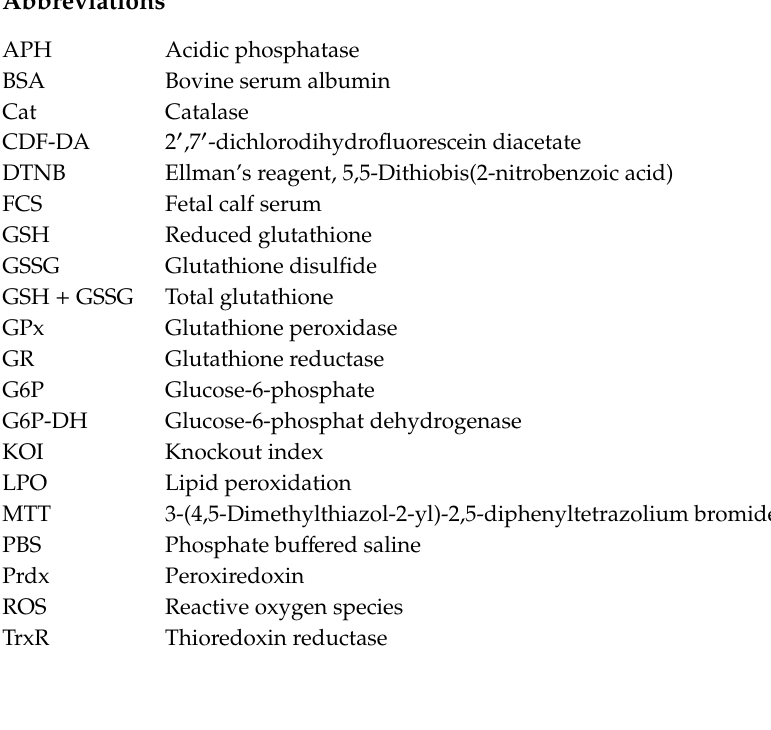
Figure S1: Position of the frameshift mutation within the GPx1 gene, Figure S2: Sequencing result of clone, mapped on NM_000581, Figure S3: Representative western blot of human GPx1 in various cell lines; corresponding signals in HAP-1 and KO.HAP-1.GPx1 cells are tagged. Positive GPx1 control was done with bovine GPx, Figure S4: Representative dot plots from flow cytometric analysis of the Annexin V-FITC / PI Assay in untreated HAP-1 and KO.HAP-1.GPx1 cells determining background apoptosis, Figure S5: Representative western blot of human GPx4 in HAP-1 and KO.HAP-1.GPx1 cells, Figure S6: Representative western blot of human catalase in various cell lines; corresponding signals in HAP-1 and KO.HAP-1.GPx1 are tagged, Figure S7: Representative western blot of Prx1 and Prx2 in HAP-1 and KO.HAP-1.GPx1 cells, Figure S8: Representative western blot of human Trx1 in